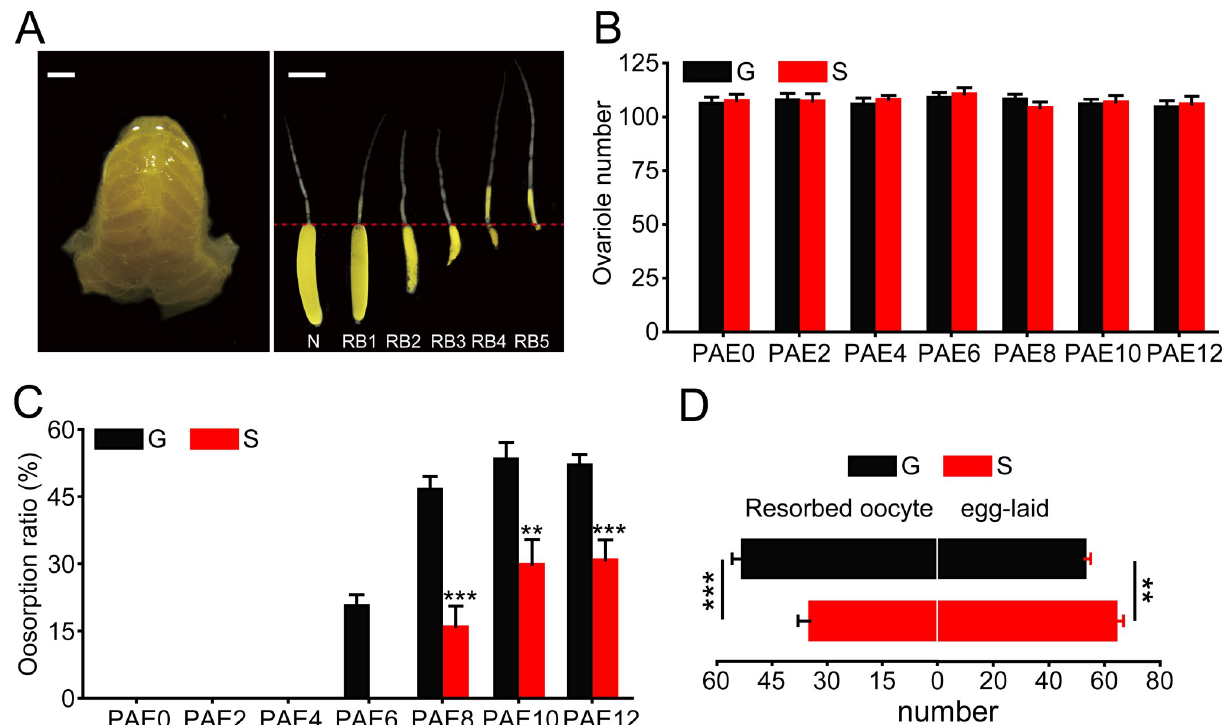
Fig 1. Oosorption differences between gregarious and solitarious locusts. (A) Normal and resorbed terminal oocytes at different stages. N, normal terminal oocyte; RB, resorption body. Scale bar, 2 mm. (B) Ovariole number of gregarious or solitarious adults at PAE0, 2, 4, 6, 8, 10 and 12. n = 15. (C) Oosorption ratio of gregarious or solitarious adults at PAE0, 2, 4, 6, 8, 10 and 12. n = 10–18. (D) The number of resorbed terminal oocytes and eggs in the first egg pod in the gregarious or solitarious adults. n = 15–16. �� P < 0.01, ��� P < 0.001.